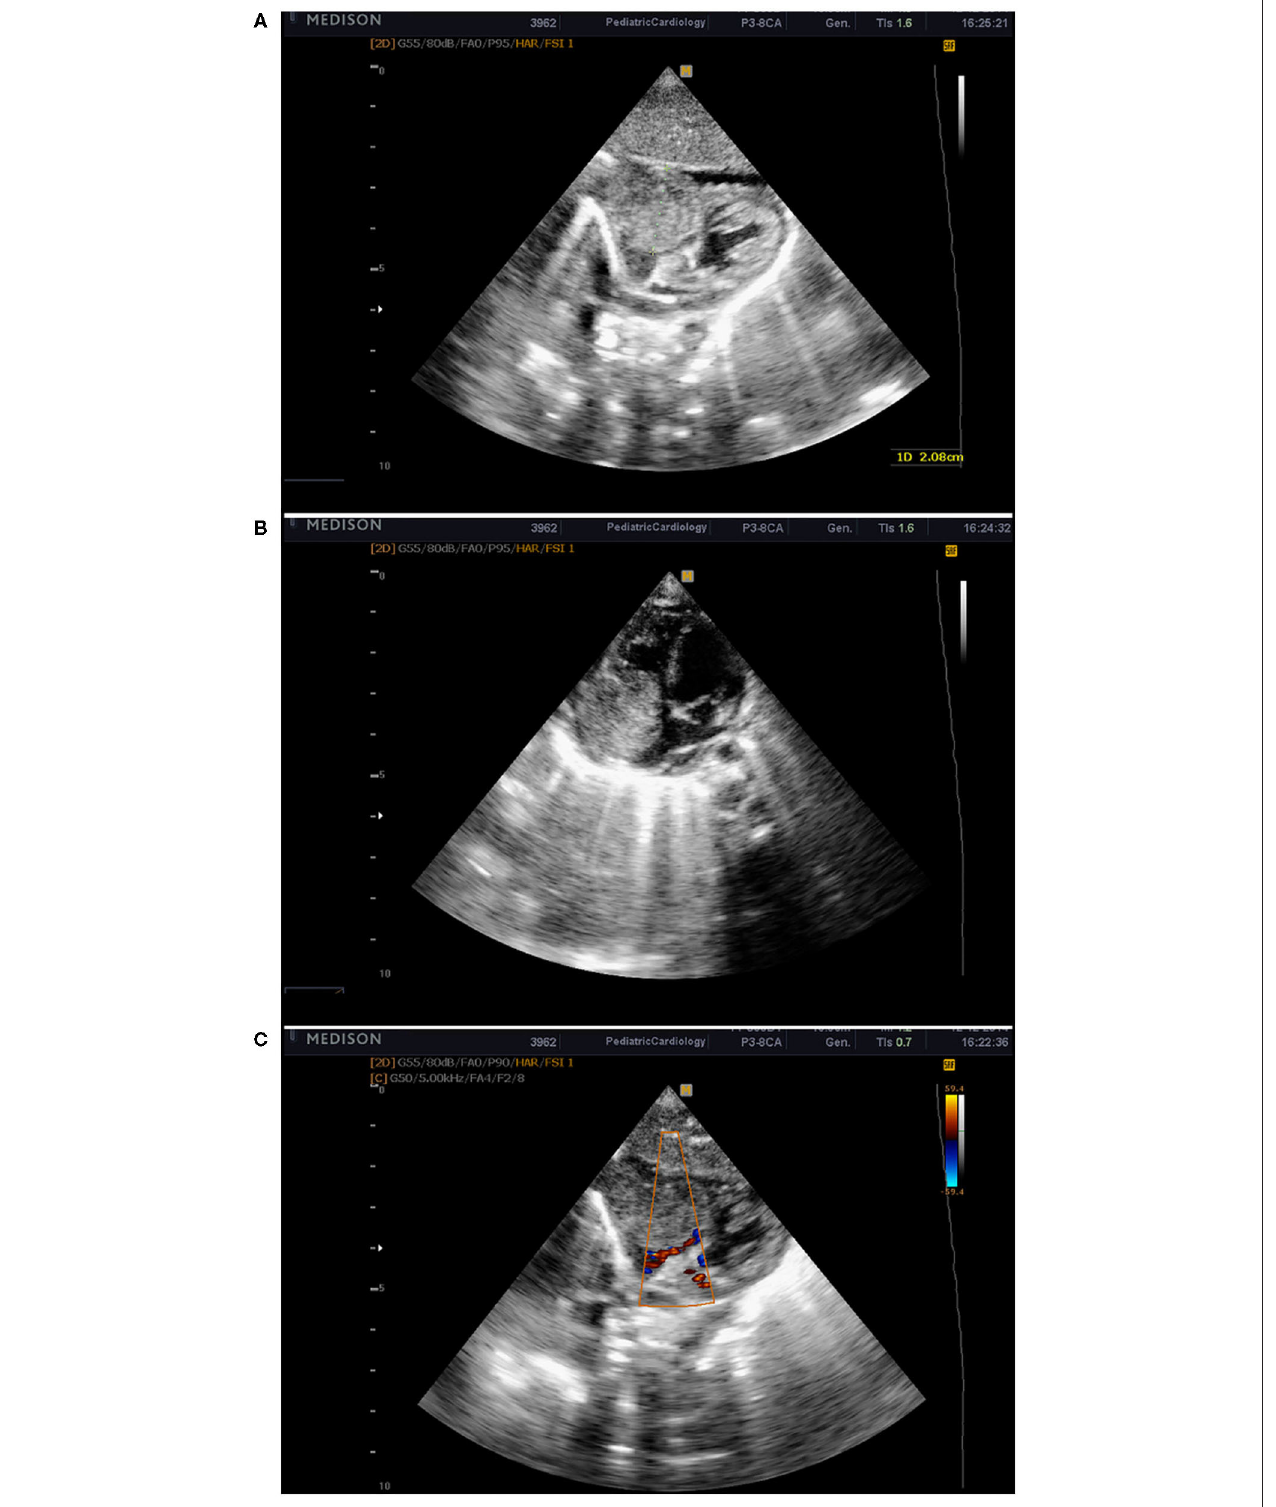
FIGURE 1 | Echocardiographic images from the subcostal window showing the tumor mass in the right atrium (A,B) . Obstruction in the output of the right atrium and reduced blood flow to the right ventricle (C) .